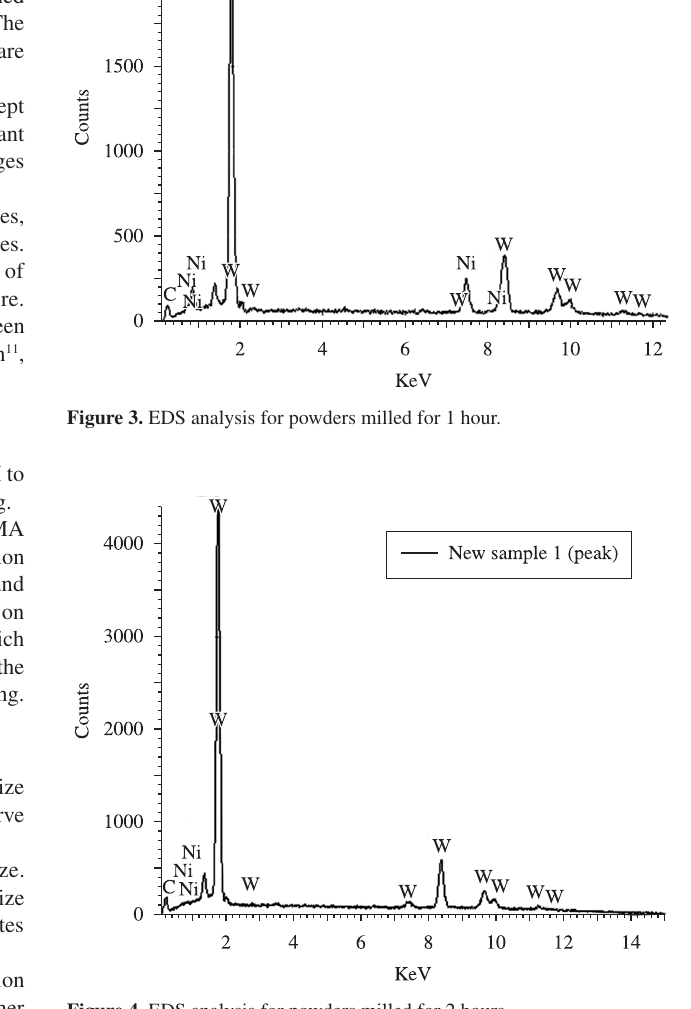
Figure 4. EDS analysis for powders milled for 2 hours.